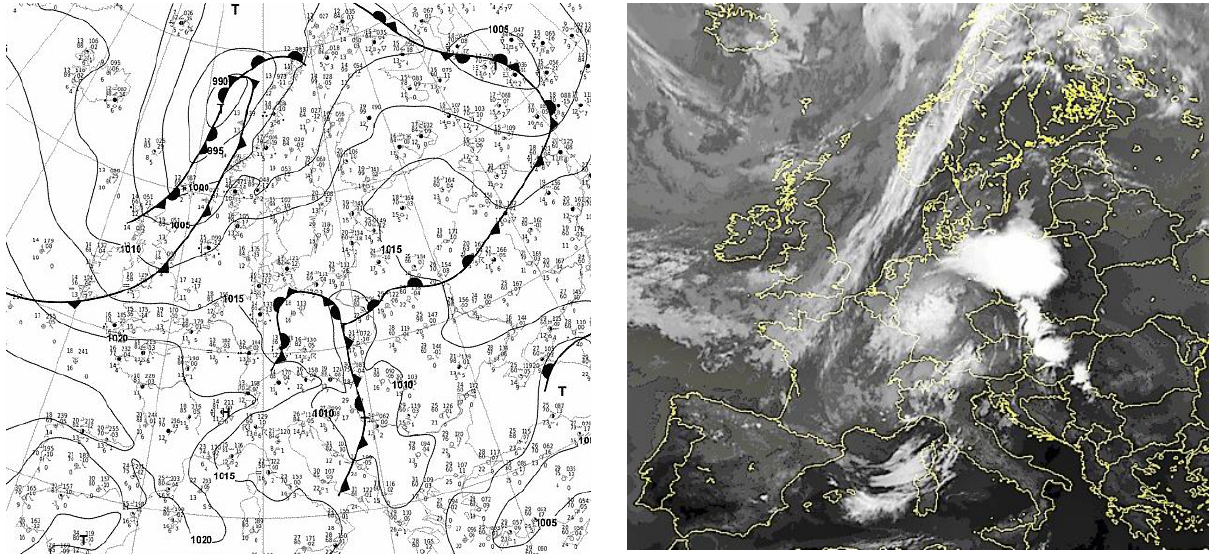
Fig. 2. Synoptic charts of Europe from 12.08.2017 00:00 UTC (left). Source: www.wetter3.de The MSG satellite image of Europe 22:00 UTC infrared channel (right). Source: